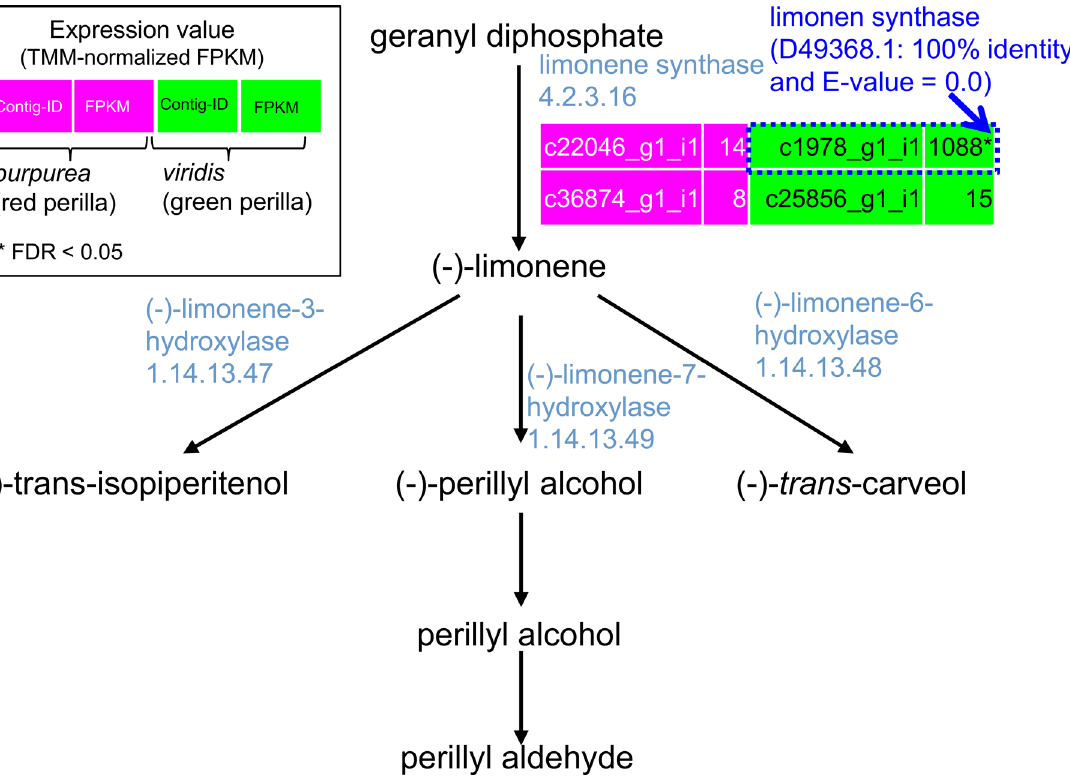
Fig 6. Comparative representation of transcriptome data in red and green perilla plants. Biosynthetic pathways and the expression of unigenes involved in the biosynthesis of perillyl alcohol are displayed. The expression levels (TMM-FPKM values) of unigenes encoding the enzymes of each step are shown. Homologous genes in red and green perilla show the reciprocal best-hit BLAST results. Asterisks indicate the false discovery rate, (FDR) < 0.05, obtained with the TCC package [43]. TMM, Trimmed Mean of M values